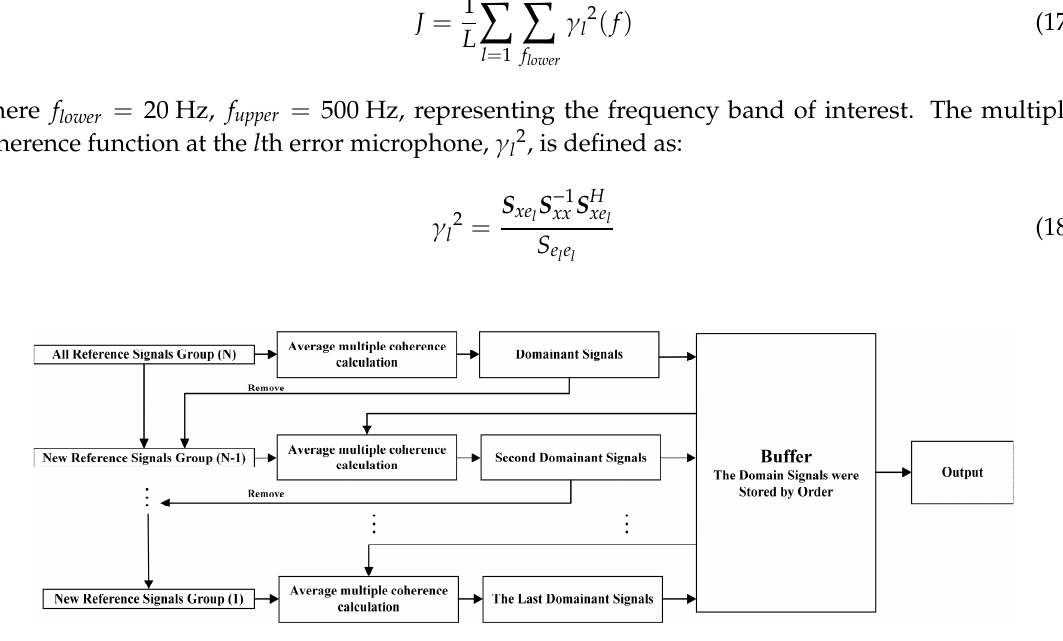
Figure 3. The flowchart of ranking the vibrational reference signals.